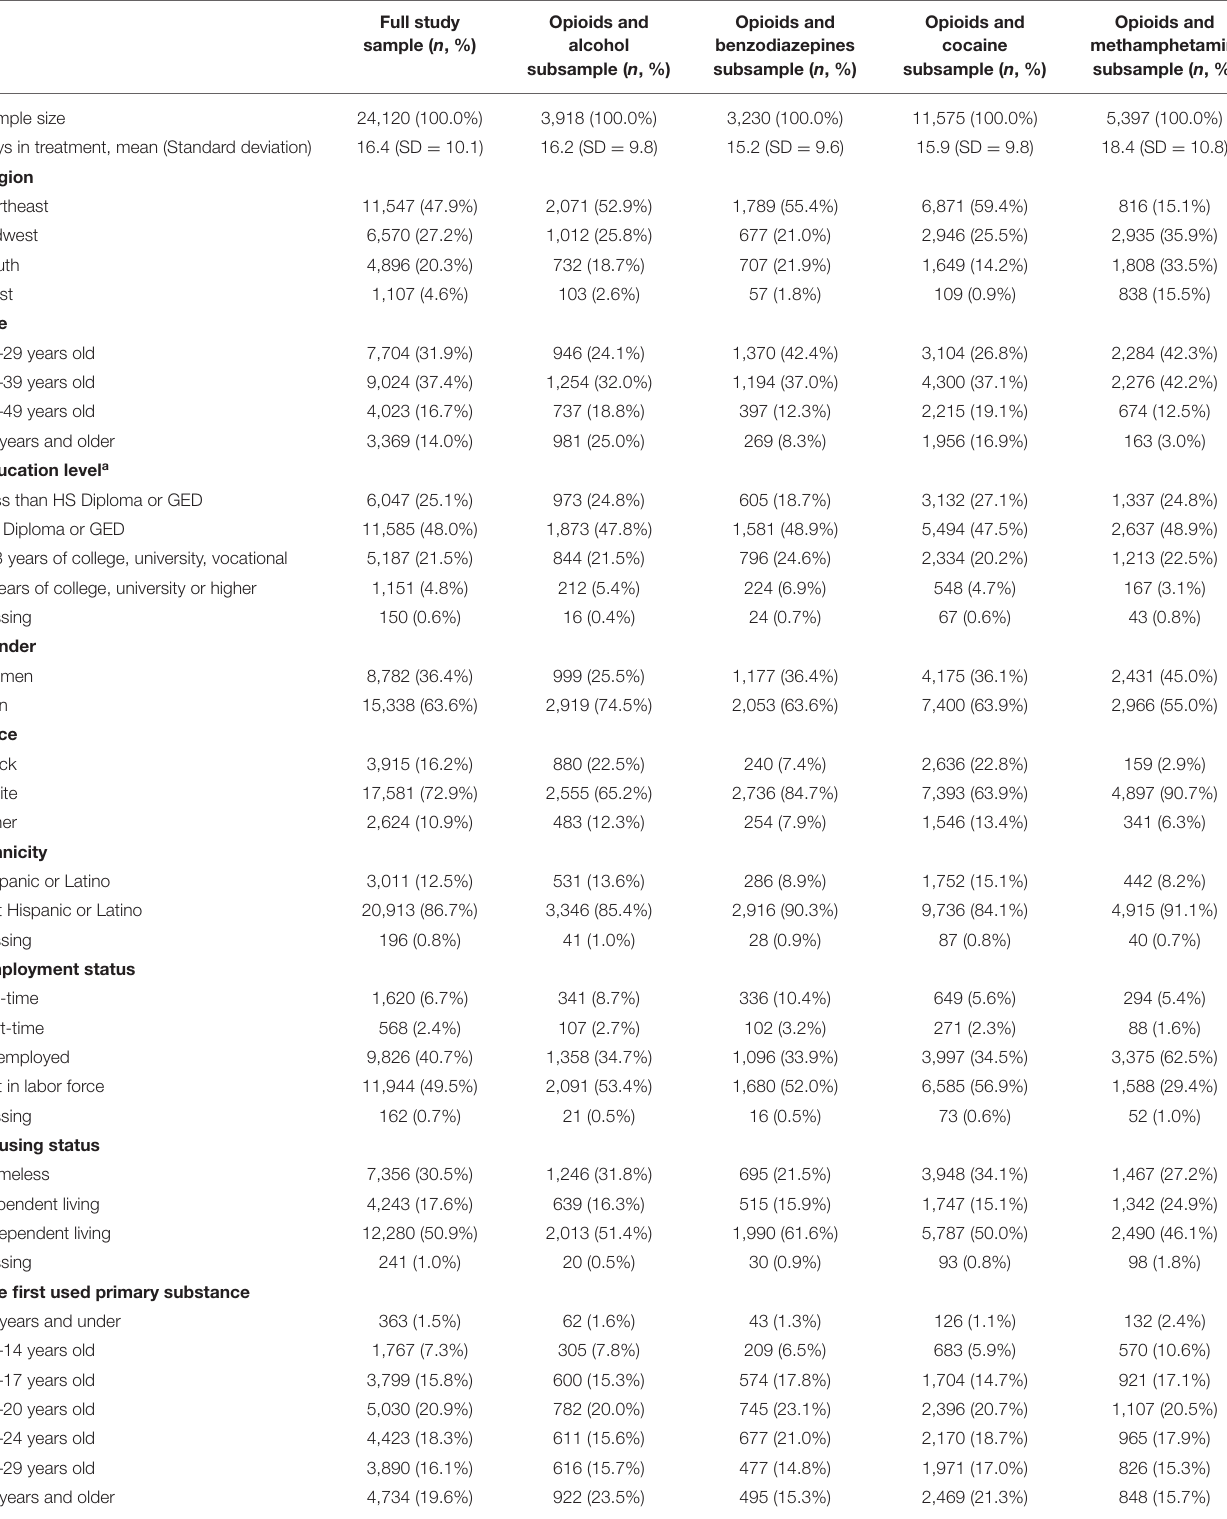
TABLE 1 | Demographic, substance use, and treatment characteristics of the full sample and co-use